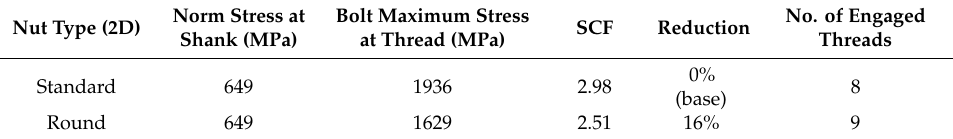
Table 6. Analysis results from 2D FE model.